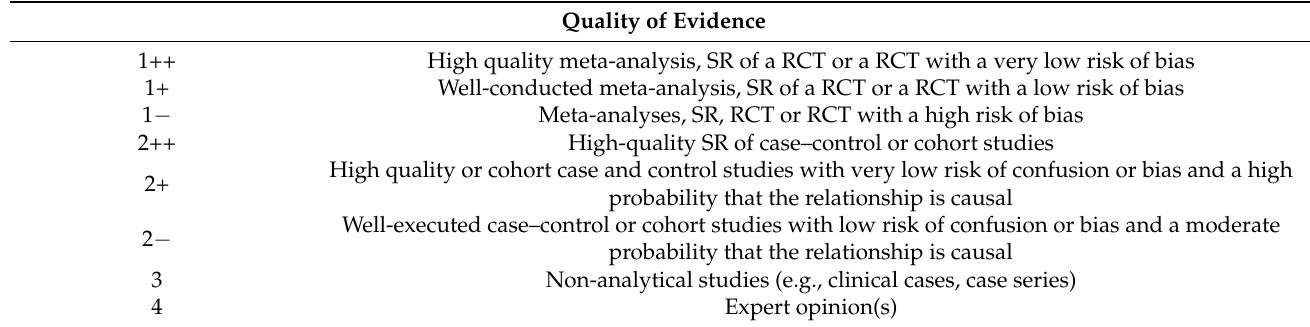
Table 1. Levels of evidence derived from the articles reviewed. Quality of